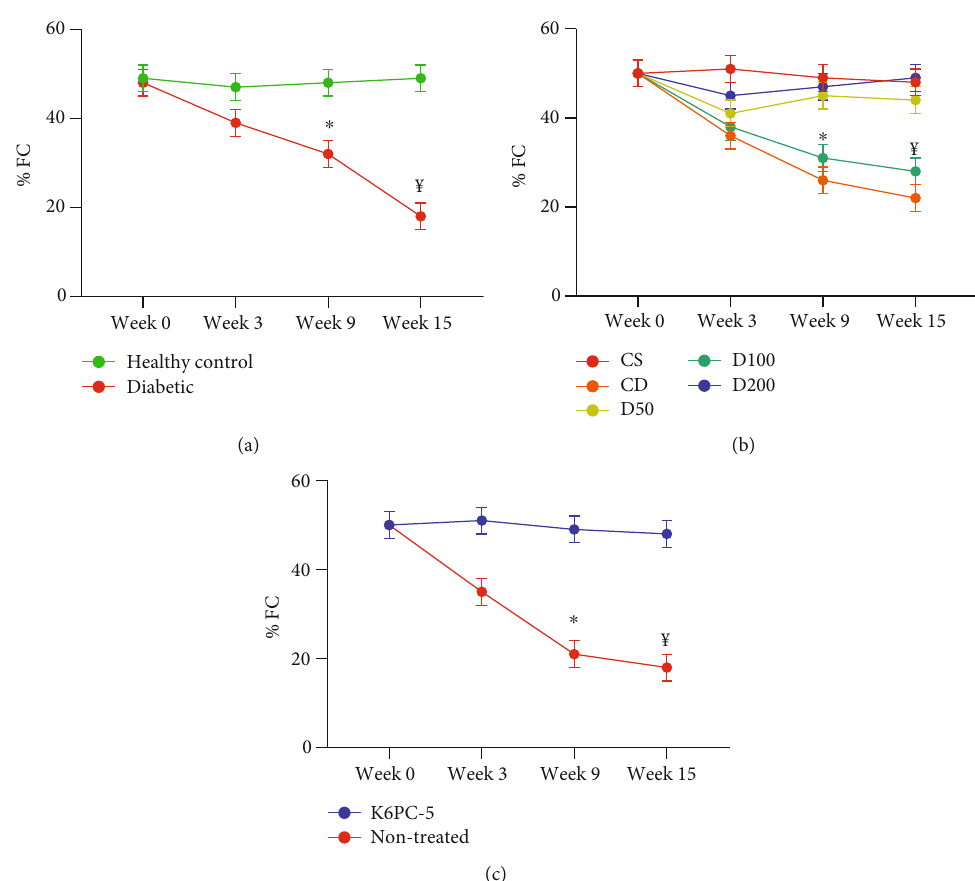
Figure 5: Mean EF and FC of studied groups throughout the experiment. (a) Healthy and diabetic groups. (b) CS, S50, S100, S200, CD, D50, D100, and D200 groups. (c) K6PC-5 and nontreated groups. ∗ p < 0 : 05 , ¥ p < 0 : 001